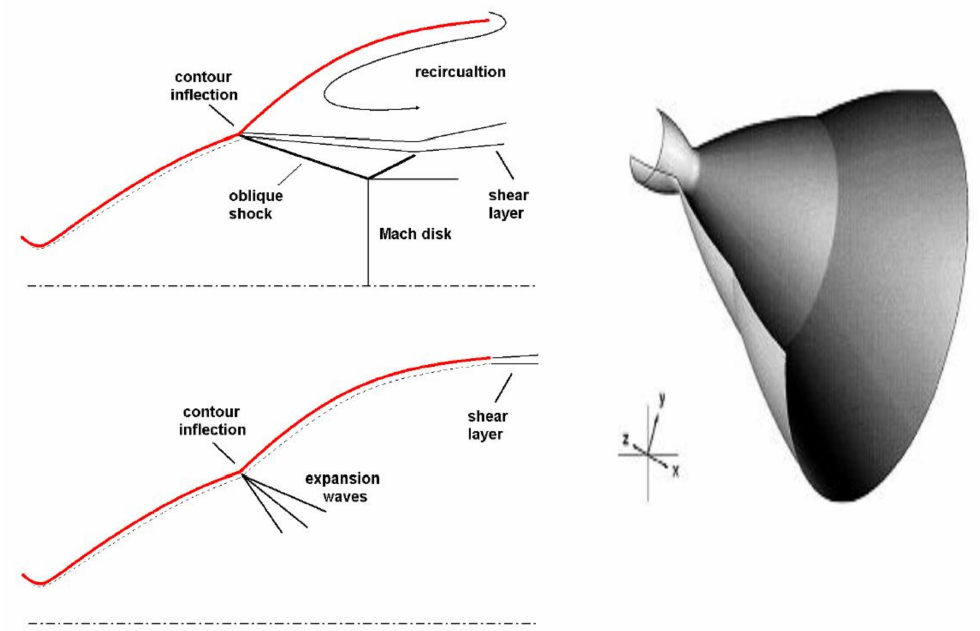
Figure 10. ( left ) Operational mode of a dual bell nozzle: separated under sea level mode ( top ) and attached in the extension under high altitude mode ( bottom ), ( right ) the dual bell nozzle in three dimensions